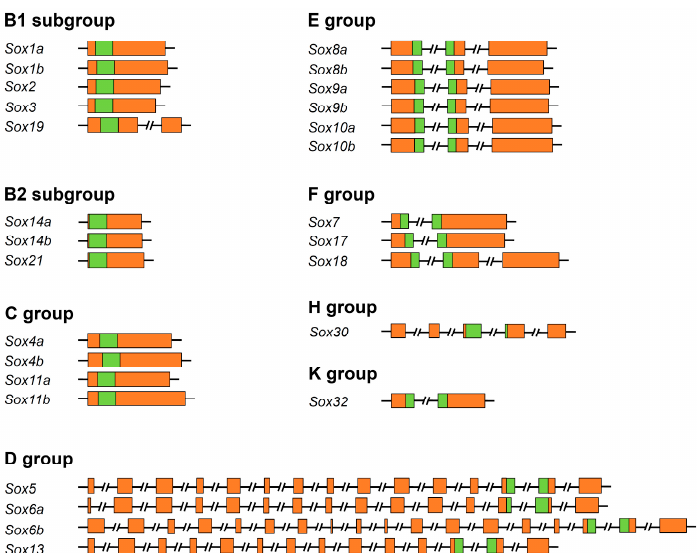
Figure 1. Exon–intron structure of the tilapia Sox genes. Rectangle and line with double slash indicate exon and intron, respectively. The HMG-box domain regions and the rest regions of the exons are highlighted with green and brown, respectively.